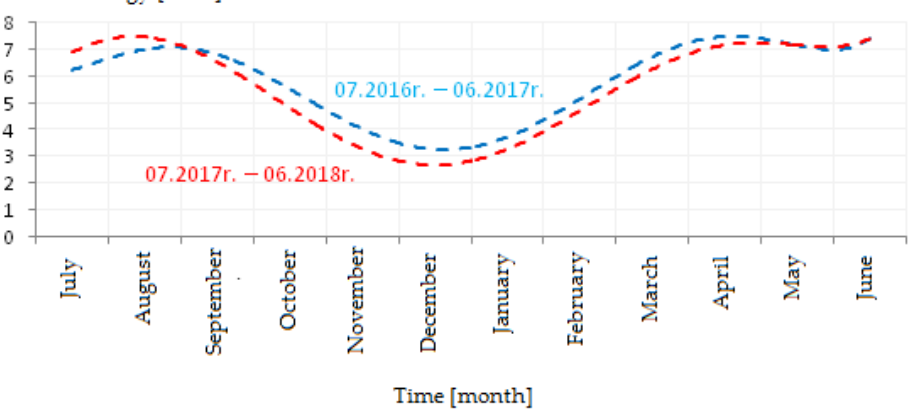
Figure 9. Changes in the consumption of electricity by electrical actuators vs. time—the first (07.2016–06.2017) and second (07.2017–06.2018) years of analysis.